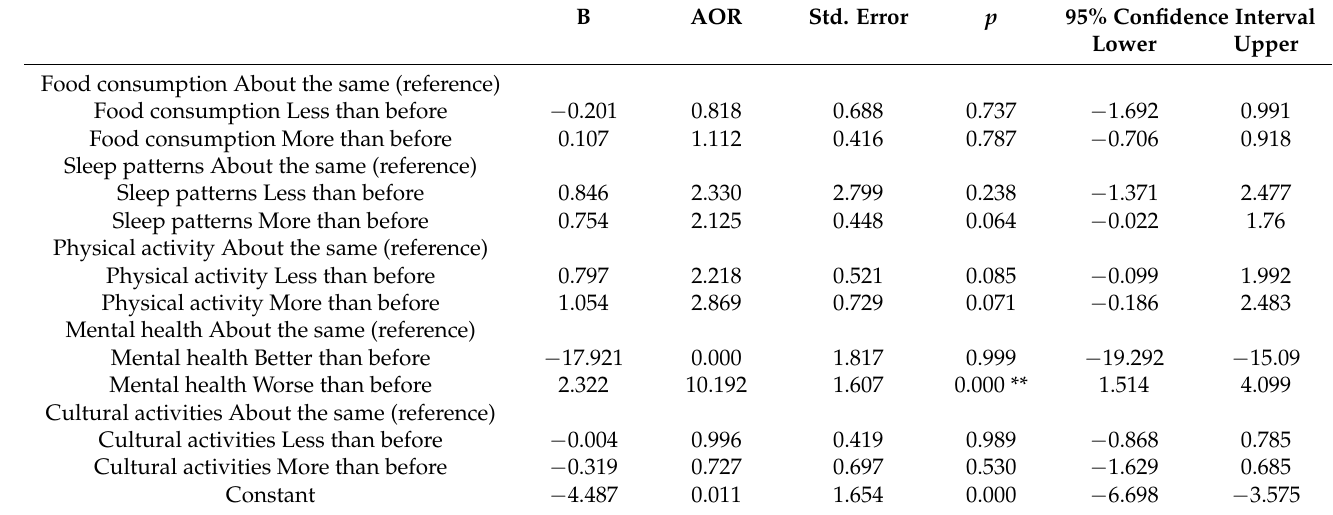
Table 4. Precipitating variables predicting move to severe loneliness ( n =